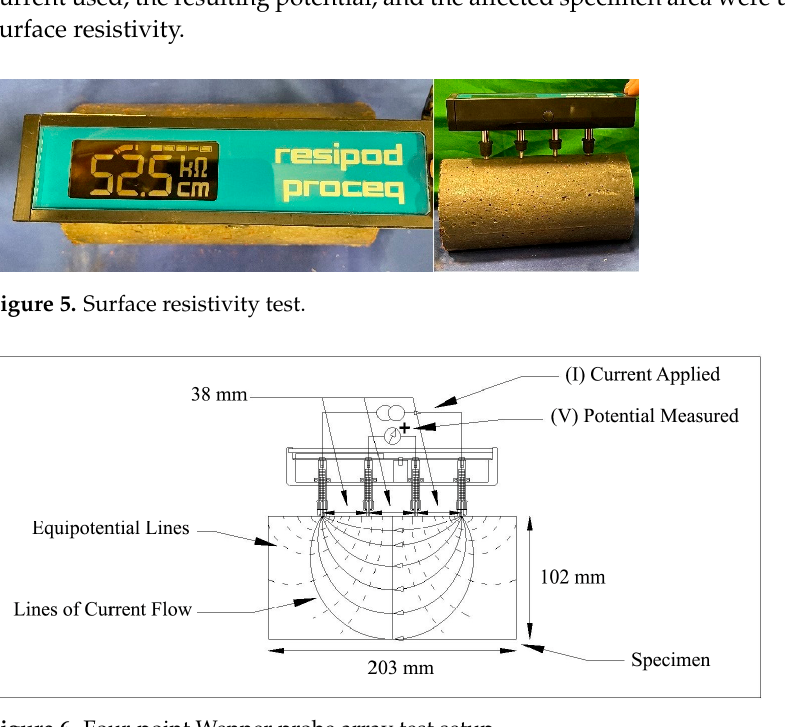
Figure 4. RCPT: ( a ) power supply and test cell and ( b ) vacuum pump and desiccator.